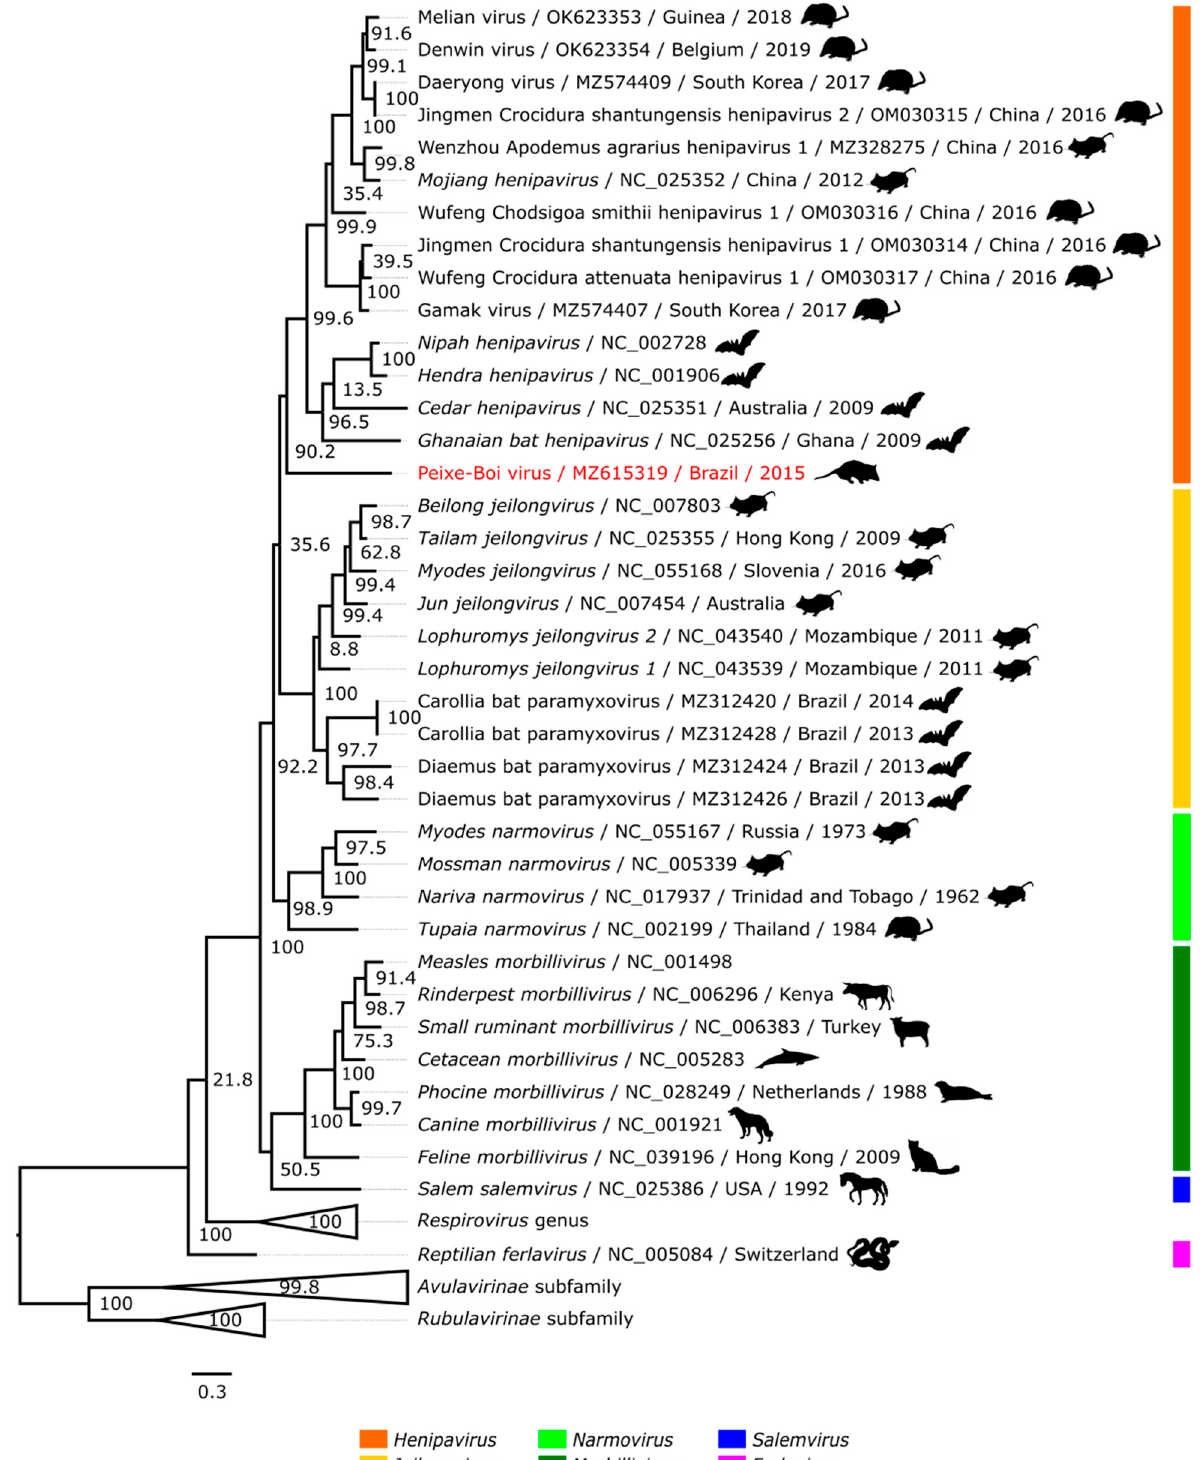
Figure 3. Phylogenetic tree based on the translated Paramyxoviridae L gene RefSeq sequences, novel rodent and shrew-borne henipaviruses and Brazilian jeilongviruses sequences. PBV (in red) partial genome was detected in a pooled tissue sample of Marmosa demerarae . Each record consists of the virus species/name, accession number, country, and year of detection/isolation and next to the icon of the original host of detection/isolation. Orthoparamyxovirinae subfamily is represented with genera indicated by color. The other two subfamilies and Respirovirus genus are